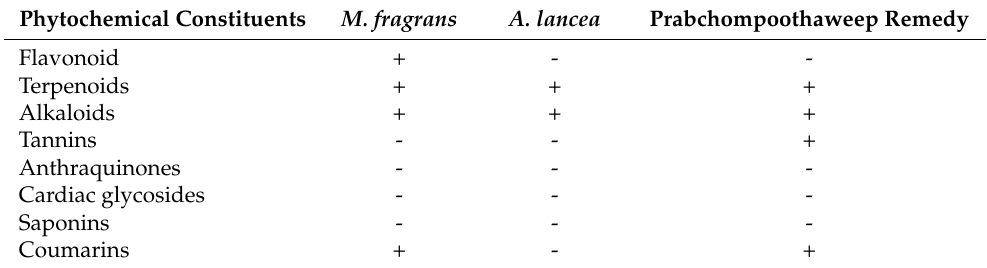
Table 1. Phytochemical screening of ethanolic extract of M. fragrans mace, A. lancea rhizome, and Prabchompoothaweep remedy.